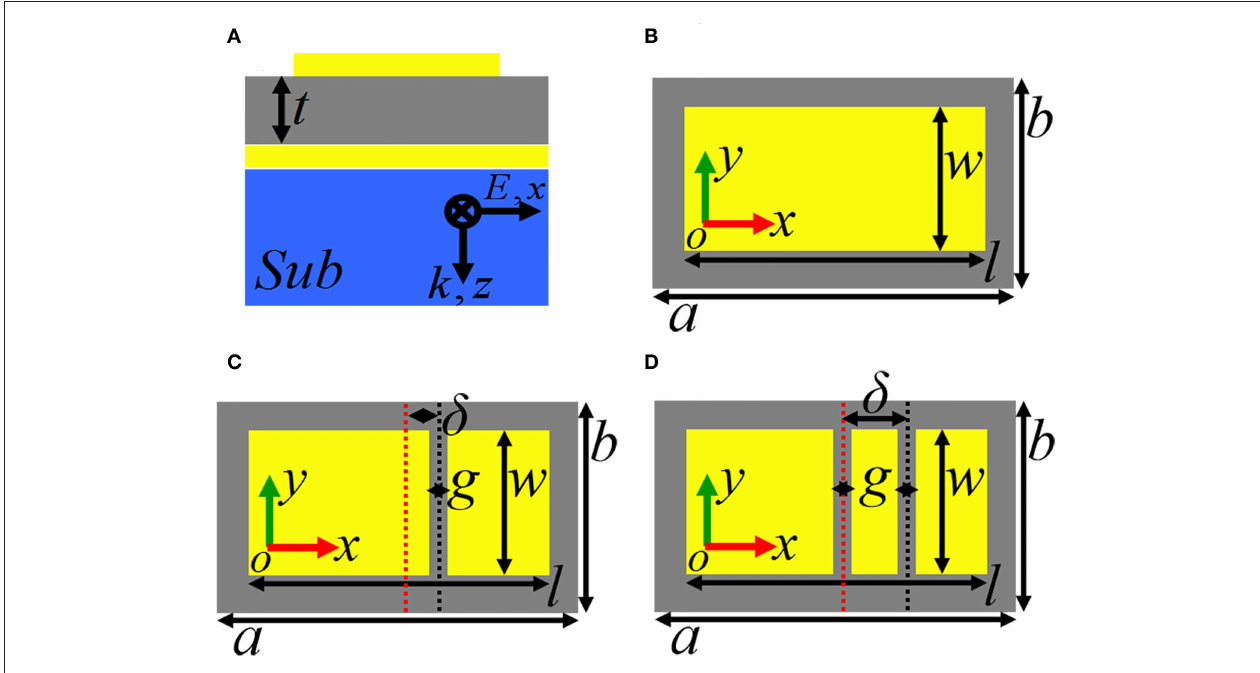
FIGURE 1 | (A) Side view of the metamaterial absorber having the single-band, dual-band, and triple-band absorption; (B) Top view of the single-band metamaterial absorber; (C) Top view of the dual-band metamaterial absorber; (D) Top view of the triple-band metamaterial absorber.